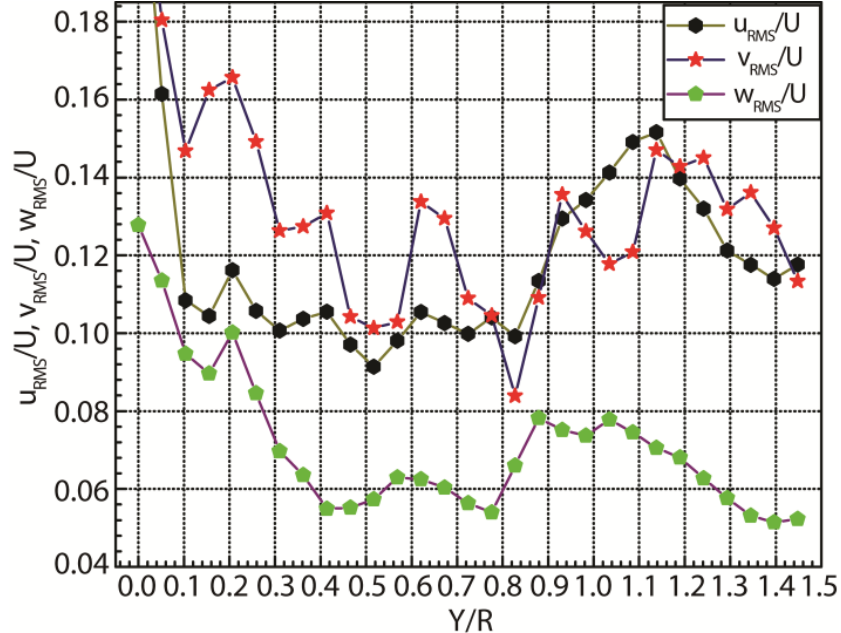
Figure 10. The root mean square velocity profiles at Z / R = 0.00 of the propeller region under the ballast condition.